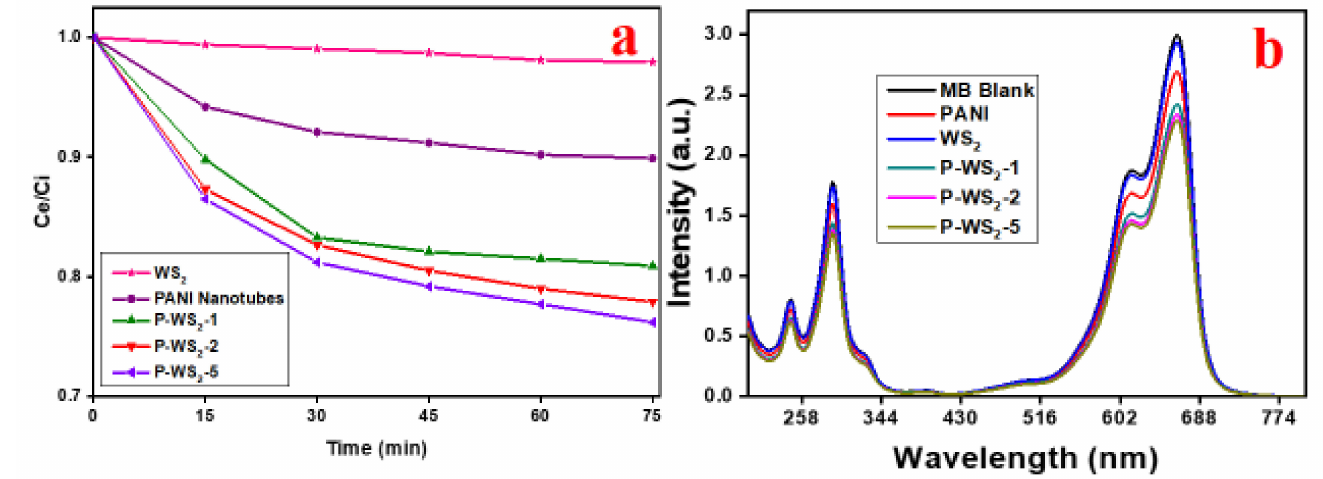
Figure 8. ( a ) Adsorption–desorption equilibrium rate of MB under dark conditions versus time in the presence of various photocatalysts ( b ) UV-vis absorption spectra of MB aqueous solution at 75-min dark adsorption–desorption equilibrium.